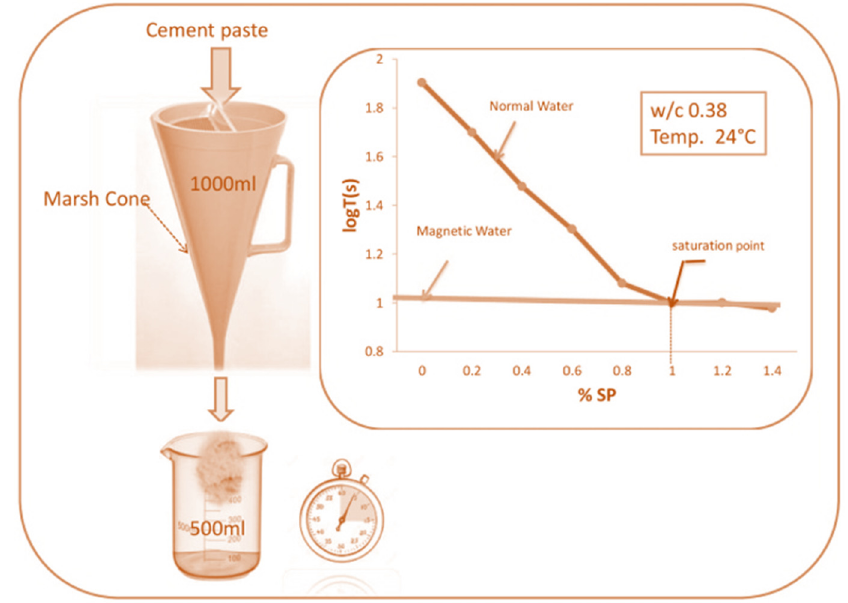
Figure 4. Marsh cone test results.